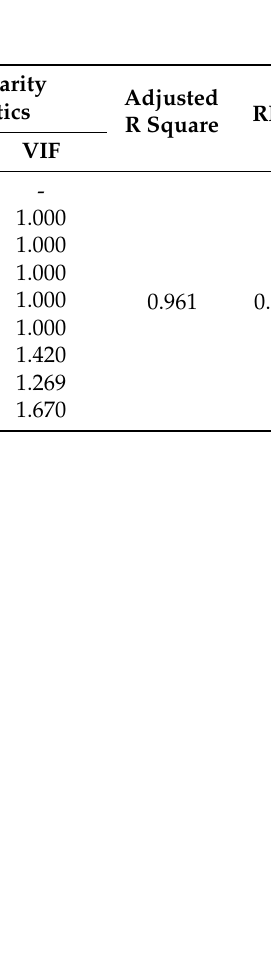
Figure 8. A scatter plot for the regression standardized residuals (n = 9071 1% of the data). Several relationships between the independent parameters and the dependent param- eter (E C ) are depicted in Figure 9. For each 3D plot, we fixed some independent parameters (bold top legend) while the remaining parameters varied. That said, the figure depicts the significant change in the energy consumption rates (at the bivariate level) resulting from the change in vehicular, operational, topological, and external parameters. The standardized coefficients (betas) are used to compare the impact of each indepen- dent parameter on the energy consumption. Accordingly, road grade has a substantial impact on the E C (Std. β = 0.945), followed by the initial state of charge (Std. β = 0.172), road condition (Std. β = 0.132), HVAC (Std. β = 0.105), passenger loading (Std. β = 0.078), driver aggressiveness (Std. β = 0.033), and stop density (Std. β = 0.050), while the average speed has the lowest weight in affecting the E C (Std. β = 0.030). The prediction model is expressed mathematically in Equation